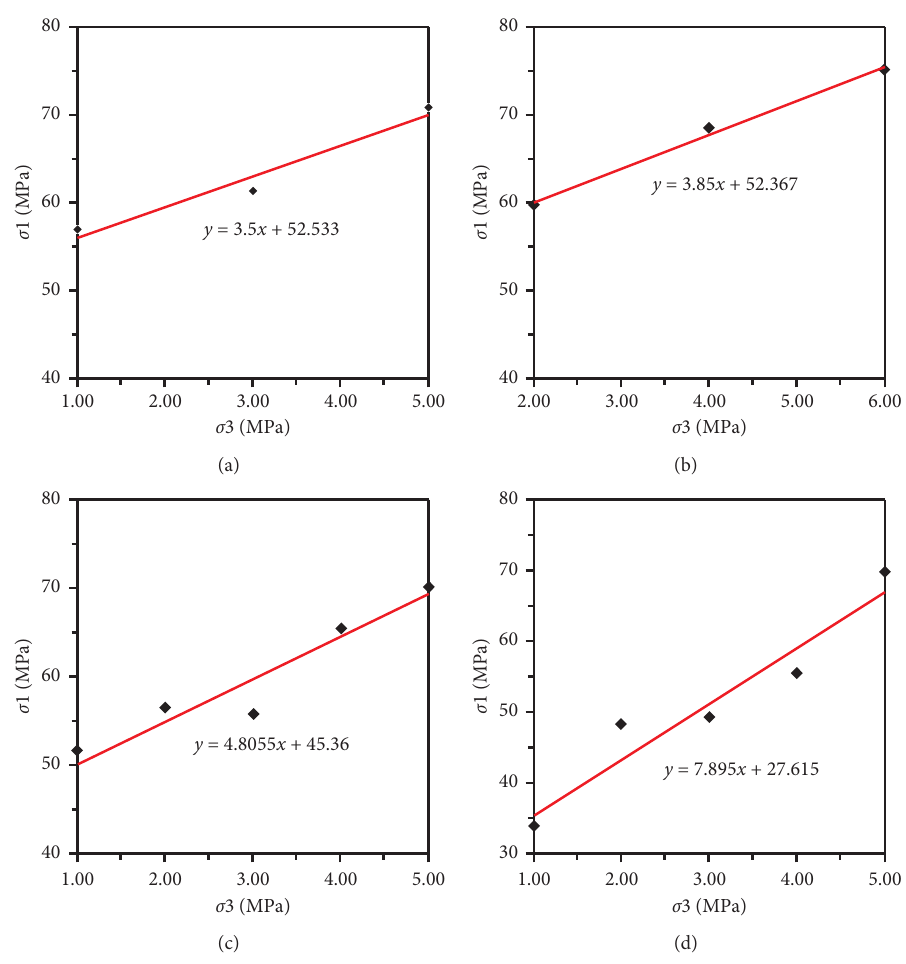
Figure 17: σ 1- σ 3 relationship curves of nonpenetrating jointed rock masses in each group. (a) B1 group σ 1- σ 3 relationship curve. (b) B2 group σ 1- σ 3 relationship curve. (c) C1 group σ 1- σ 3 relationship curve. (d) C2 group σ 1- σ 3 relationship Table 5: The c and φ values of each group of the rock mass.